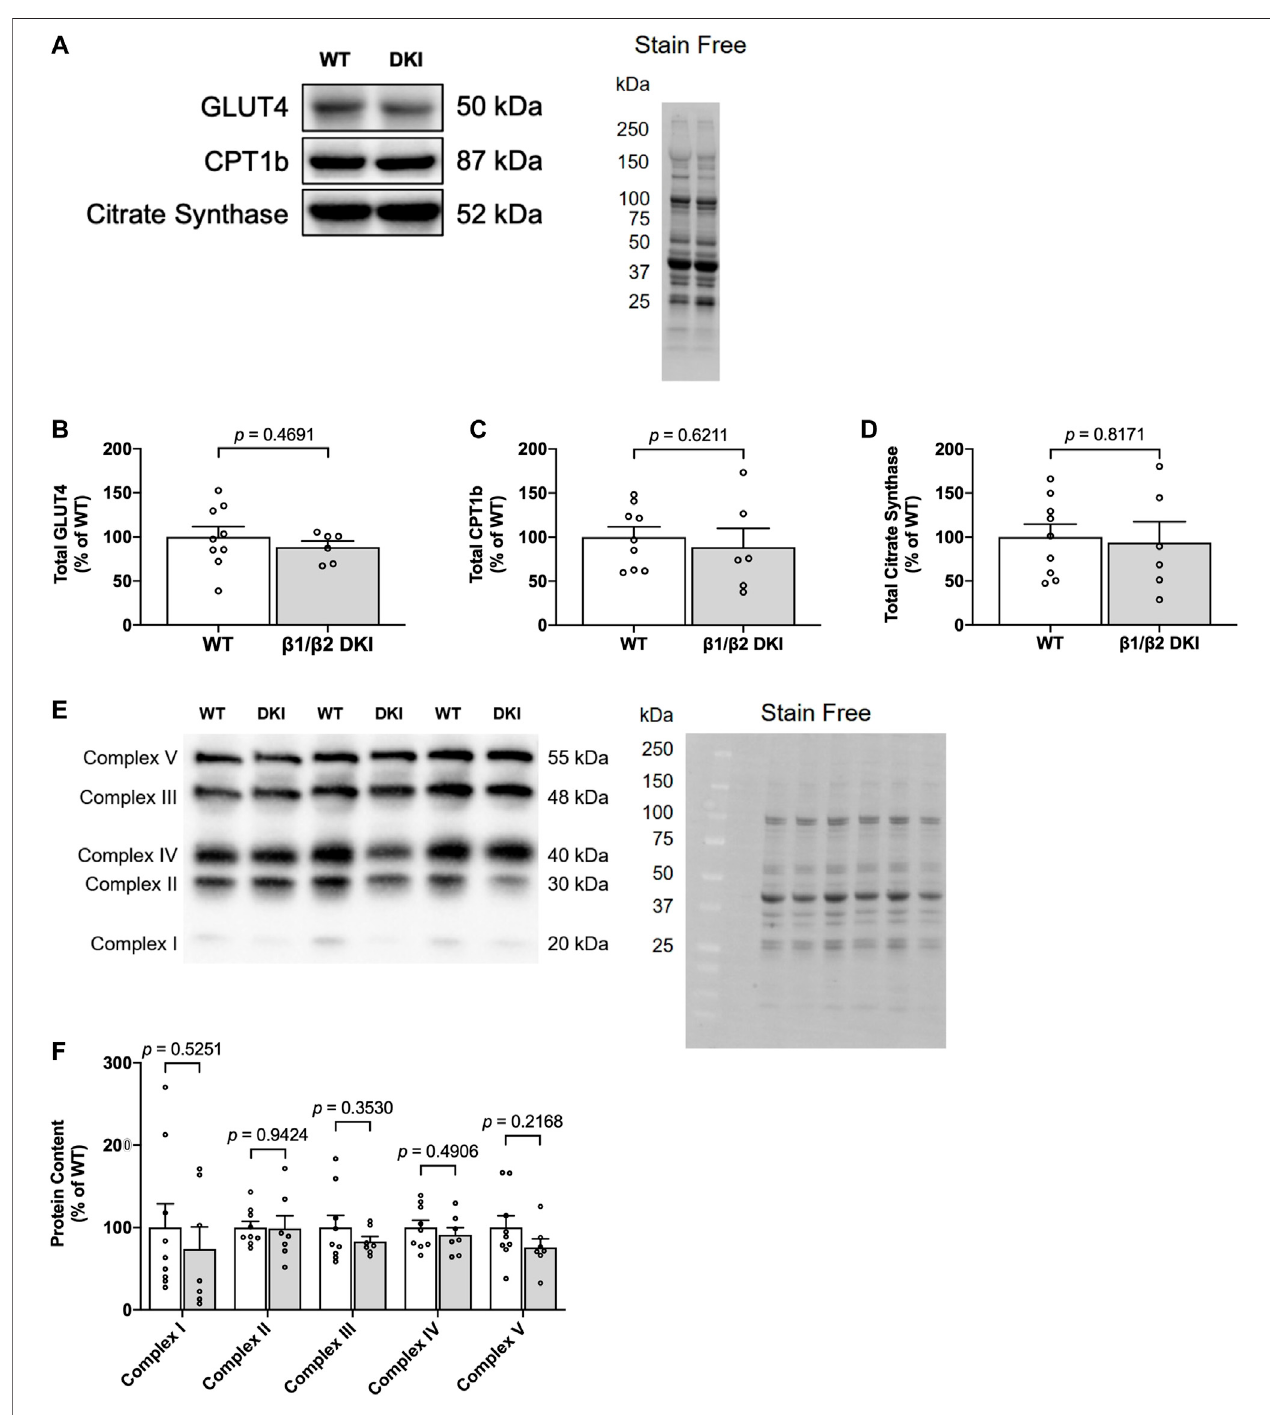
FIGURE6| DKImouseskeletalmuscledisplayssimilarcontentofproteinsassociatedwithglucoseuptakeandproteinmarkersofmitochondrialcontentrelativeto WT. (A) Representative immunoblots and stain free image of GLUT4, CPT1b, and citrate synthase in WT and DKI skeletal muscle; (B) Quanti fi ed total GLUT4; (C) Quanti fi edtotalCPT1b; (D) Quanti fi edtotalcitratesynthase; (E) Representativeimmunoblotsandstainfreeimageofmitochondrialoxidativephosphorylation(OXPHOS) complex proteins in WT and DKI skeletal muscle; (F) Quanti fi ed OXPHOS complex protein content. Male mice, 20 – 32 weeks, n = 7 – 9.